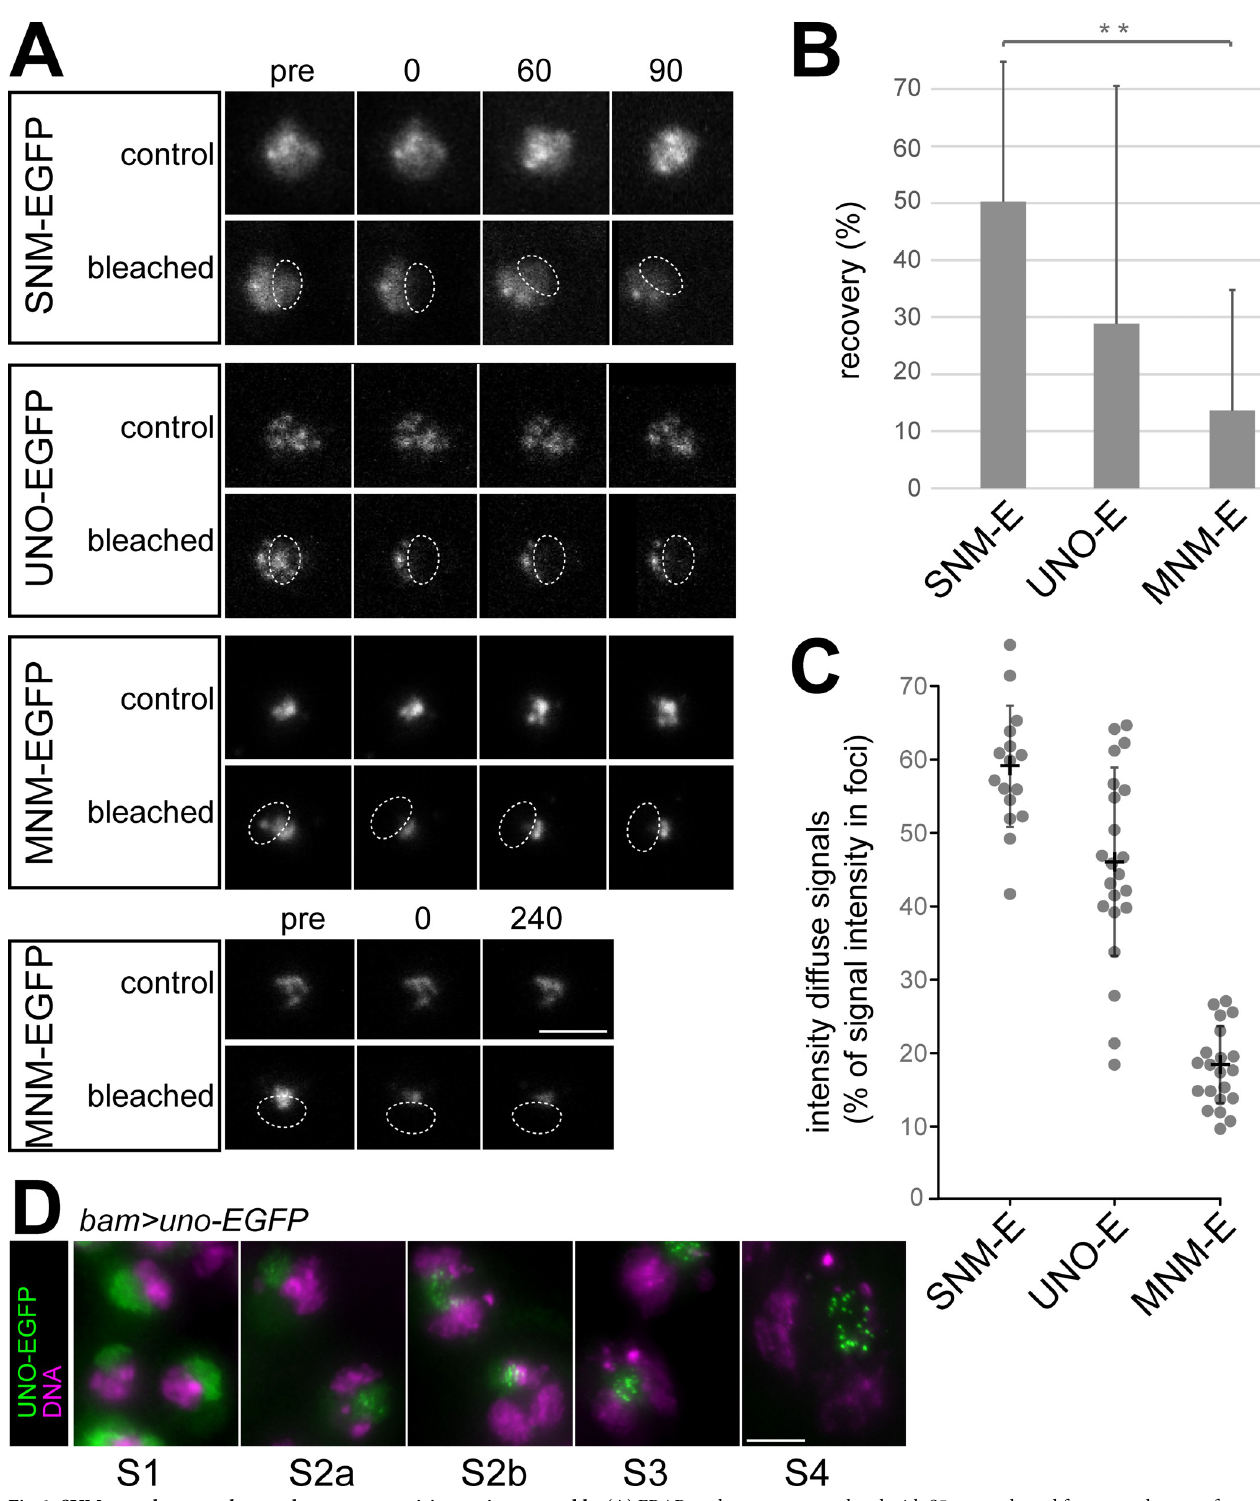
Fig 6. SUM complexes on the sex chromosome pairing region are stable. ( A ) FRAP analyses were completed with S5 cysts released from pupal testes of males expressing the indicated UASt transgenes driven by bam-GAL4-VP16 . A subregion of the nucleolus (dashed oval) was bleached in one of the spermatocytes at t = 0. Still frames from representative control and bleached spermatocytes are displayed immediately before bleaching (pre) and at the indicated time points (min). ( B ) The extent of fluorescent signal recovery at 90 minutes after photobleaching was quantified. Bars indicate average and